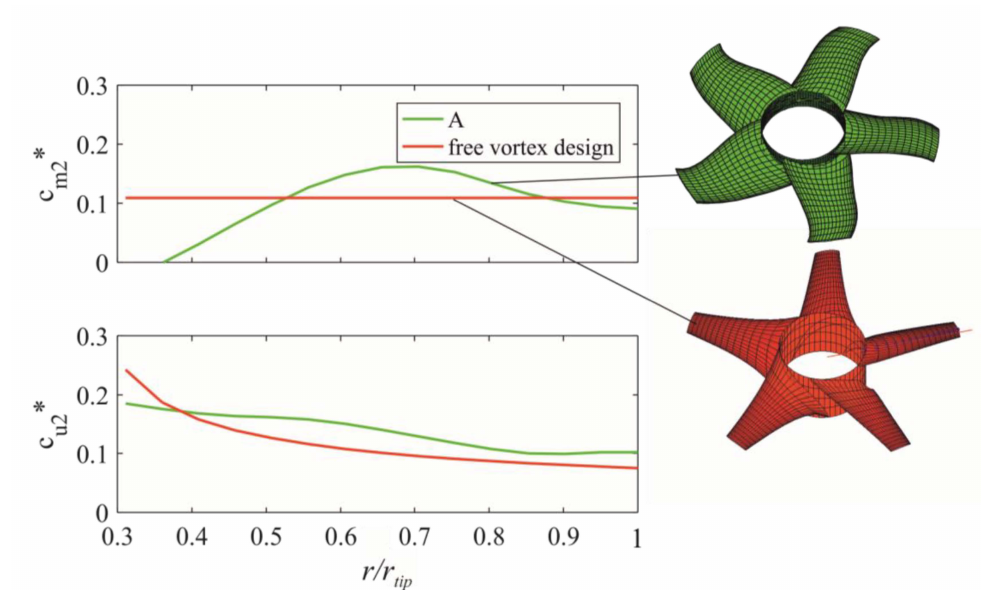
Figure 8. Comparison of optimal fan impeller A with a standard textbook design (i.e., free vortex, rc u 2 = const and c m 2 = const according to the requirement of radial equilibrium); the velocities are normalized with the blade tip speed π D tip n , indicated by the star as a